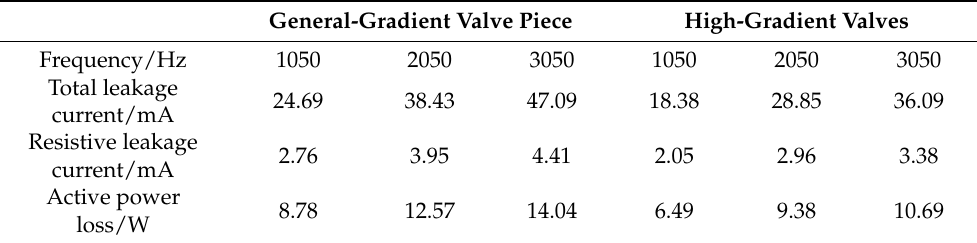
Table 3. Contrasts in test outcomes for zinc oxide valves with various potential